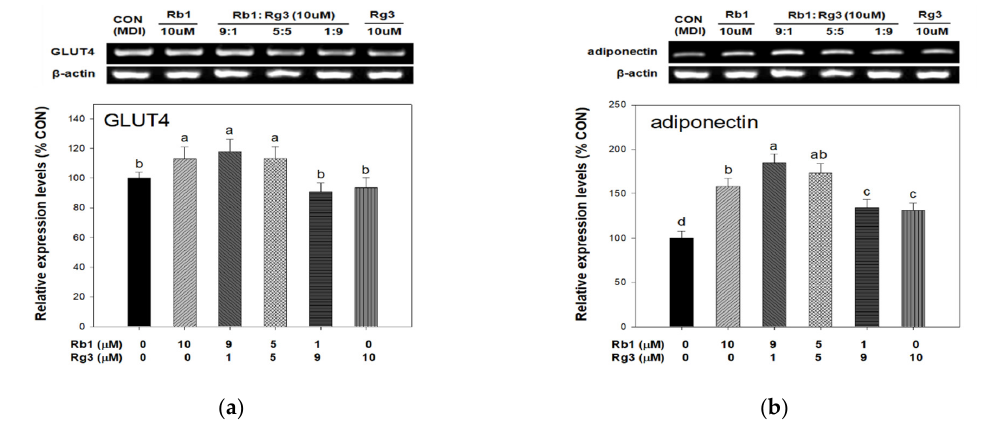
Figure 5. Effect of combined ginsenosides Rb1 and Rg3 on the expression of GLUT4 and adiponectin mRNAs expression during the differentiation of 3T3-L1 preadipocytes. Values are the means ± SDs of four samples. a–d Bars with different letters indicate statistically significant differences among groups at p < 0.05.